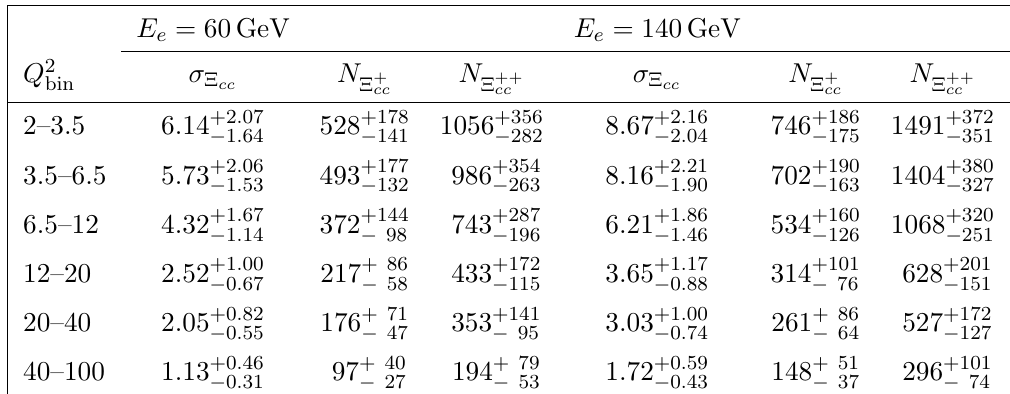
Table 1 . The integrated cross sections (unit: pb) of (cid:4) cc corresponding to di(cid:11)erent Q 2 bins (unit: GeV 2 ) under the kinematic cuts in equation (3.1). N (cid:4) ++ events per year, reconstructed by the decay chains of (cid:4) + cc and (cid:4) ++ ! (cid:3) + K (cid:0) (cid:25) + (cid:25) + with (cid:3) + cc c